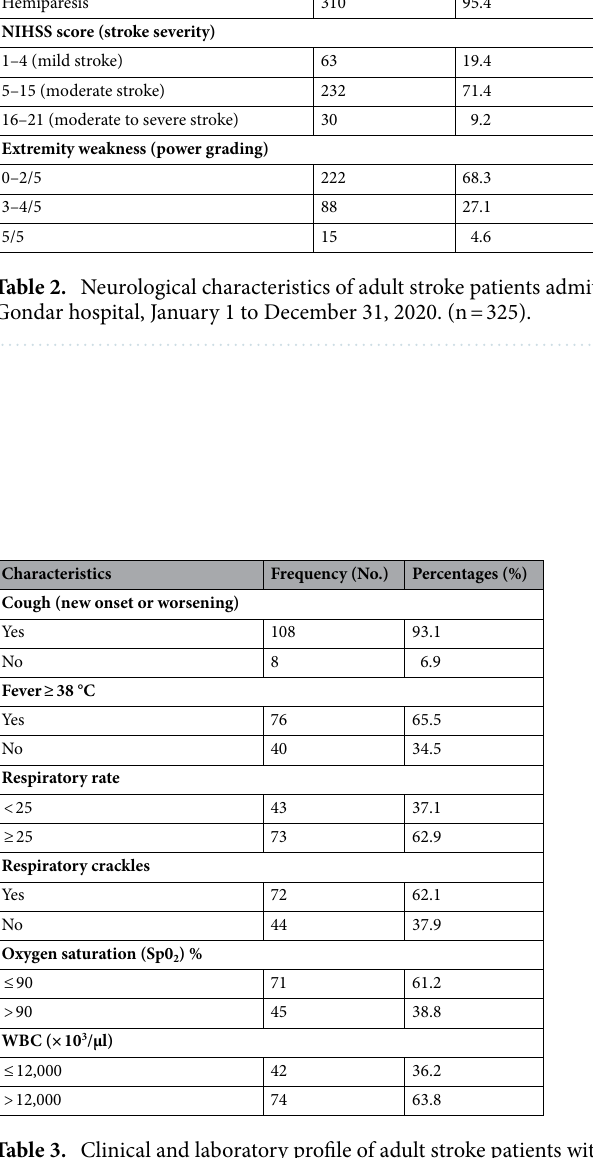
Table 3. Clinical and laboratory profile of adult stroke patients with stroke associated pneumonia admitted to Stroke Care Unit, University of Gondar hospital, January 1 to December 31, 2020. (n =